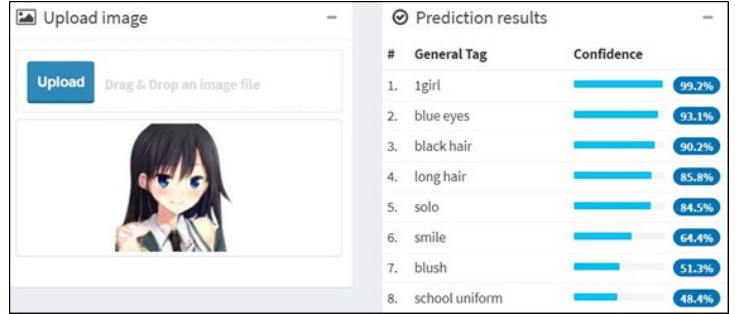
Figure 6. Example application of illustration2vec [42]. The model recognizes several attributes of the character such as her haircut and clothes. The web demo used to generate this image is not online